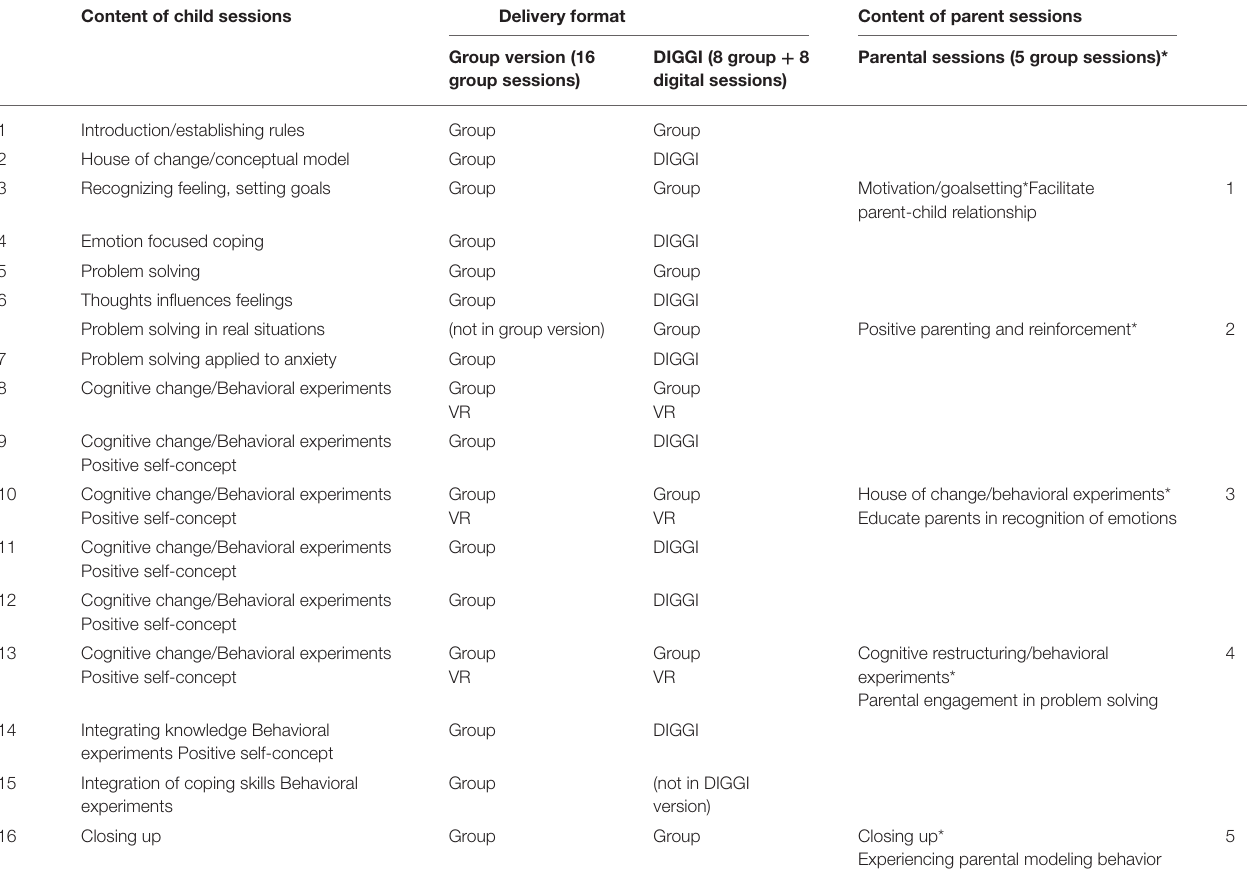
TABLE 2 | Content of EMOTION; child and parent